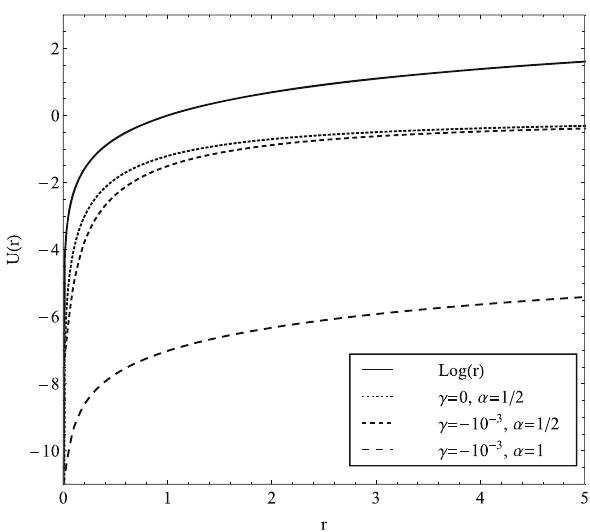
Fig. 2 The effective potential for 3 D linearized softly massive quadratic gravity